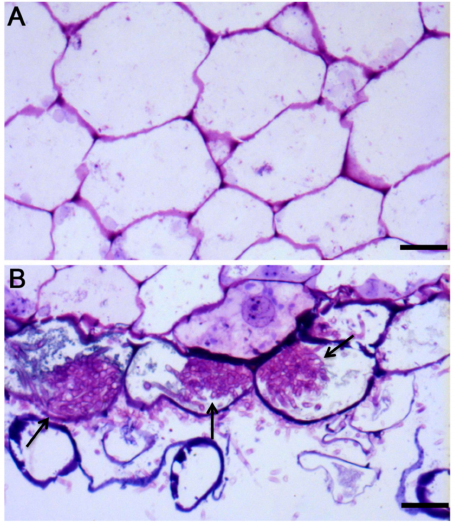
Figure 1. The semi-thin sections of root of A. roxburghii after two weeks of symbiotic cultivation. ( A ) the control, scale bar = 50 mm; ( B ) the treatment; arrows represent pelotons, scale bar = 50